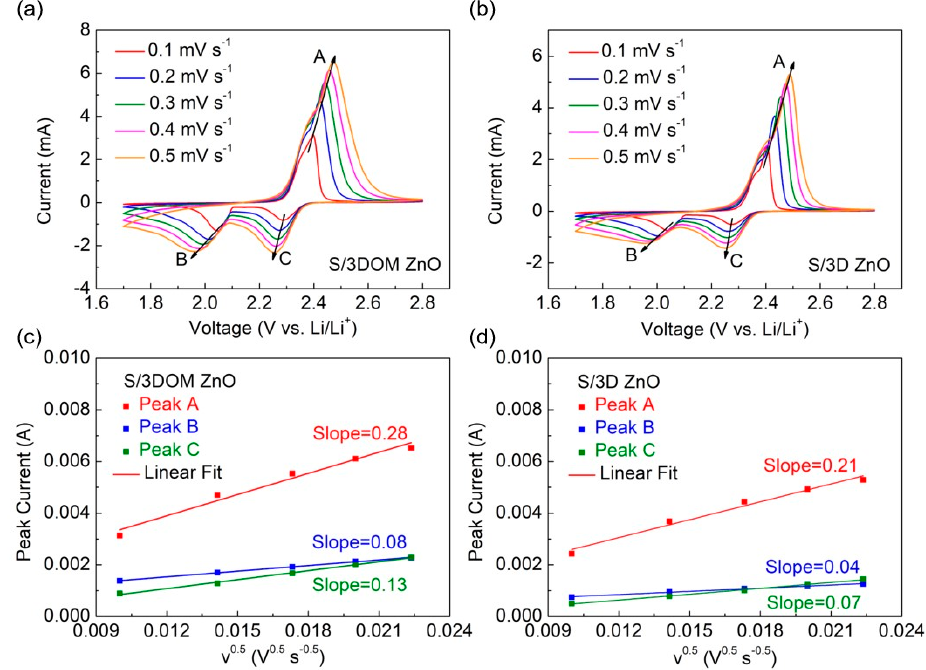
Figure 5. Cyclic voltammetry (CV) curves at various scan rates for ( a ) S / 3DOM ZnO and ( b ) S / 3D ZnO electrodes; fitting plots of peak current (I p ) versus the square root of the scan rate ( ν 0.5 ) for ( c ) S / 3DOM ZnO and ( d ) S / 3D ZnO electrodes.